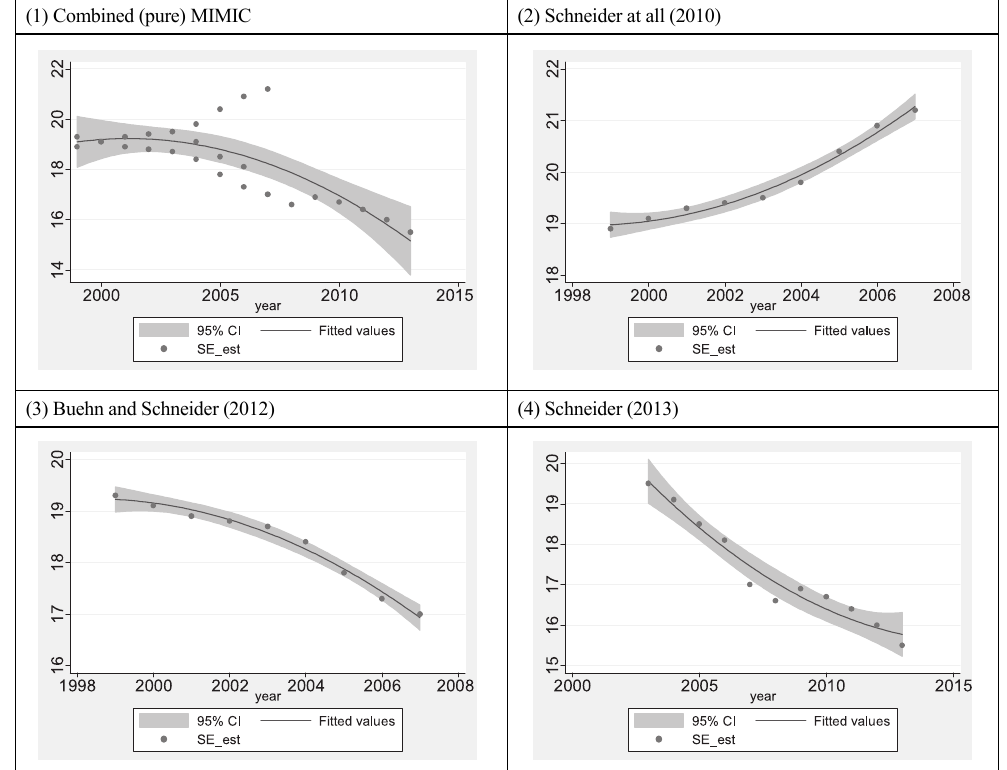
Figure 2 : Recent Macro Estimates Using MIMIC Method, for the Czech